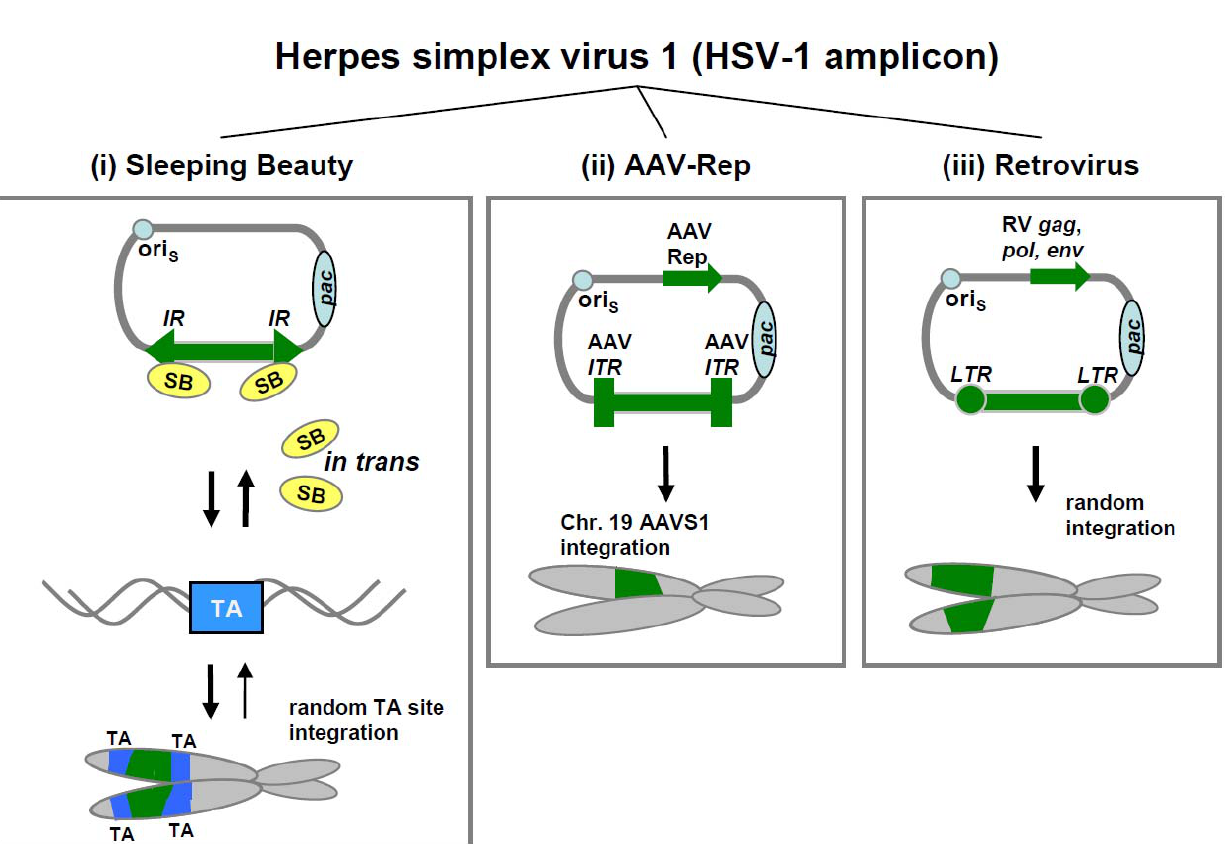
Figure 3. Mechanisms of herpes simplex virus 1 (HSV-1) amplicon based integrating hybrid vector systems. HSV-1 amplicon systems carry the HSV-1 origin of replication ( ori ), the HSV-1 packaging signal ( pac ), and the transgene flanked by specific elements s necessary for the indicated integration machinery. The DNA is packaged as concatemers into the HSV-1 virions. (i) For Sleeping Beauty (SB) transposase mediated integration the transgene is flanked by inverted repeats (IRs). The SB protein, expressed in trans , binds to the IRs excises the transposon and results in reversible random integration in TA-sites in the host genome. (ii) The HSV-1/AAV-Rep amplicon hybrid vector leads to site-specific insertion of transgenes flanked by AAV inverted terminal repeats (ITR) into the AAVS1 site of human chromosome 19. The AAV-Rep protein is produced in cis . (iii) In case of HSV-1/retrovirus (RV) amplicon vectors the transgene incorporated between two long terminal repeats (LTRs) is translocated via the retroviral proteins Gag, Pol and Env. This leads to a random integration